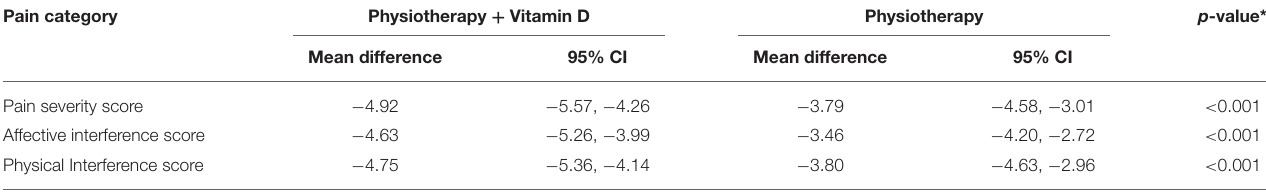
TABLE 2 | Change of pain score (mean difference before and after intervention) among physiotherapy + Vitamin D and Physiotherapy group after 12-week.